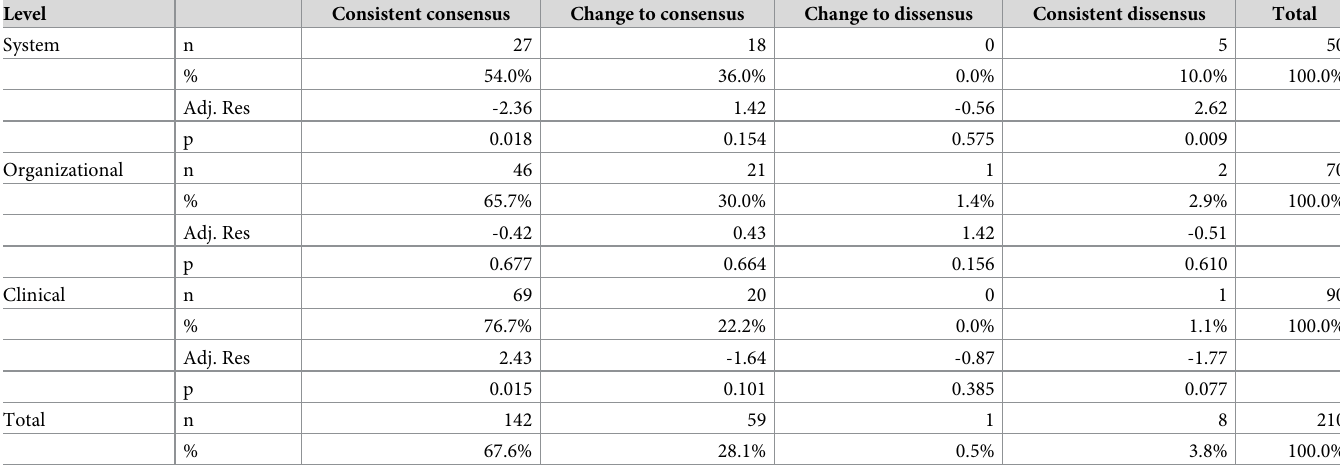
Table 3. Relationship between the level of interventions and the transition of the consensus in rounds 1 and